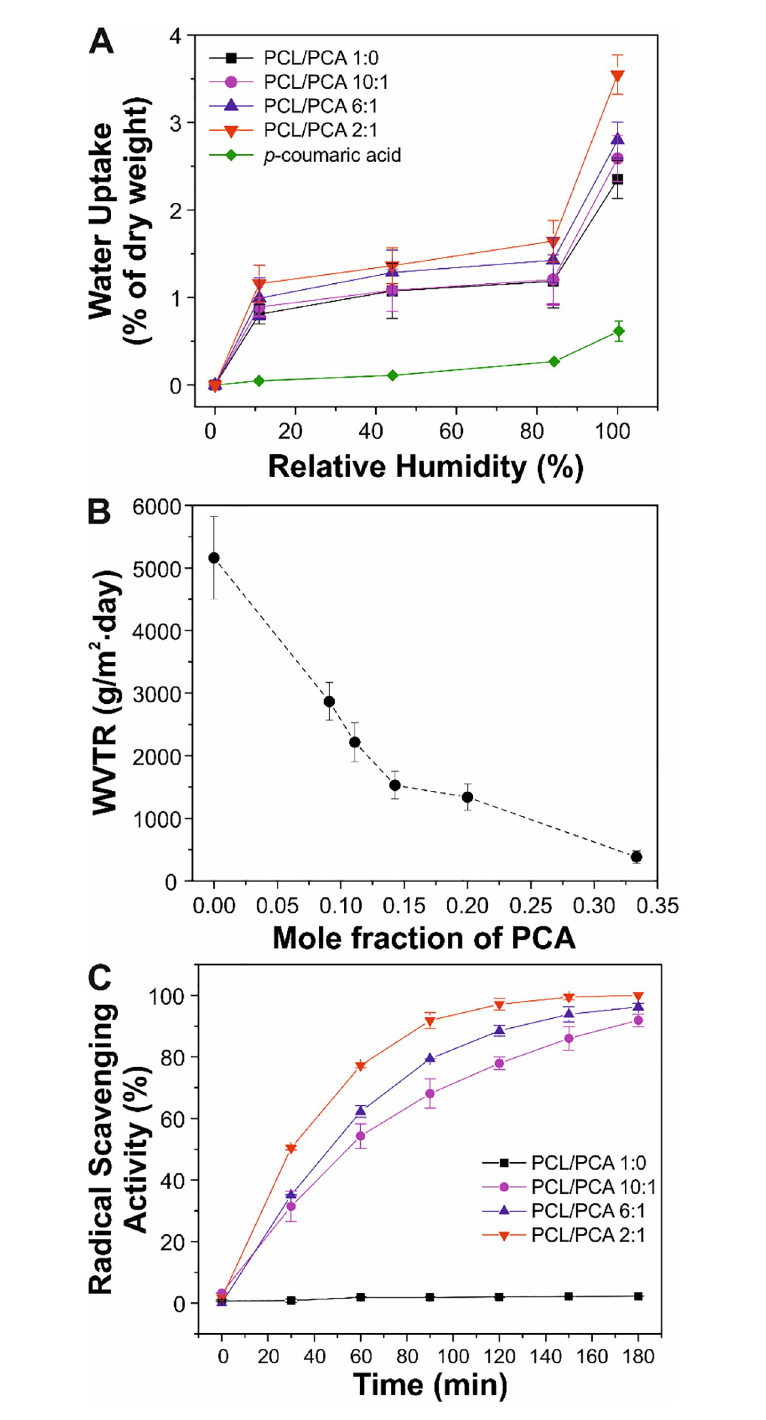
Fig 5. Evaluation of the water uptake, breathability, and antioxidant properties of the biopolymers. (A) Variation of the water uptake of PCL/PCA 1:0, 10:1, 6:1, and 2:1 and pure p -coumaric acid with the relative humidity. (B) Water vapor transmission rate (WVTR) as a function of mole fraction of PCA. (C) Antioxidant capacity of PCL/PCA 1:0, 10:1, 6:1, and 2:1 copolymers by using DPPH � free radical cation scavenging method.